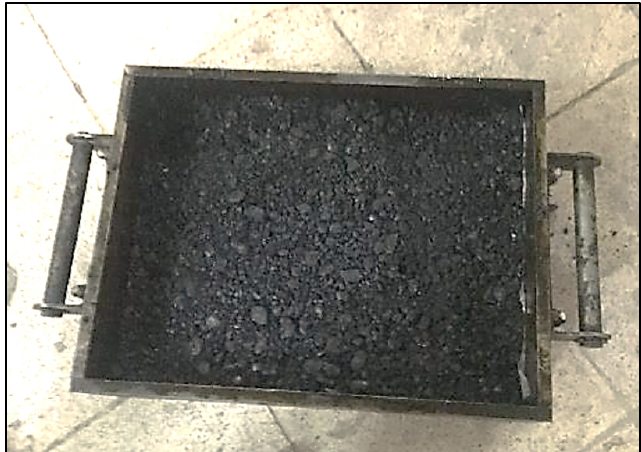
Figure 10. Pneumatic compactor.